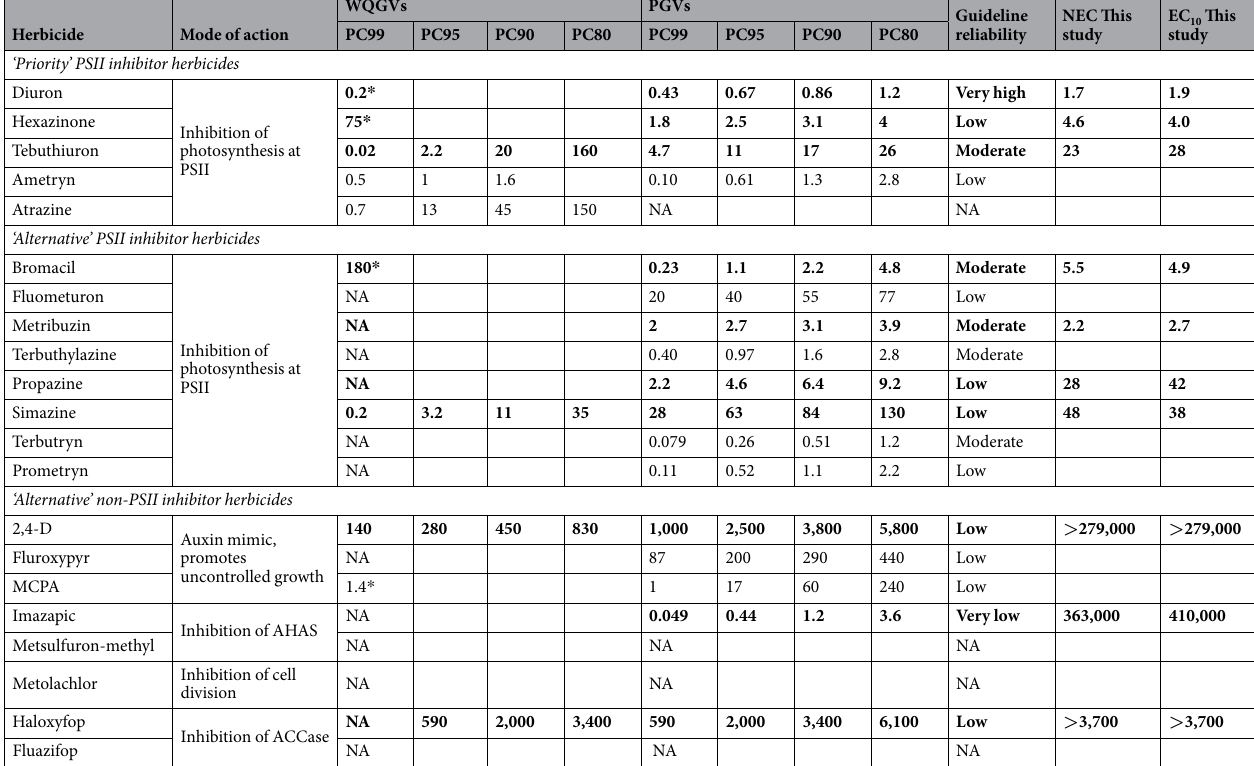
NA NA NA Table 1. Summary of detected herbicides in the GBR and its catchment. Comparison of water quality guideline values (WQGVs) 39 (all of low reliability) based on freshwater species and proposed water quality guideline values (PGVs) 43,44,93 for 99%, 95%, 90% and 80% species protection (based on marine and freshwater species) against toxicity thresholds [no effect concentration (NEC); effect concentration inhibiting the specific growth rate by 10% (EC 10) )] values derived for Rhodomonas salina in this study (from Table 3). All concentrations in µ g L − 1 . NA signifies no available guideline values. Bold indicates herbicides tested in this study. * Level of protection